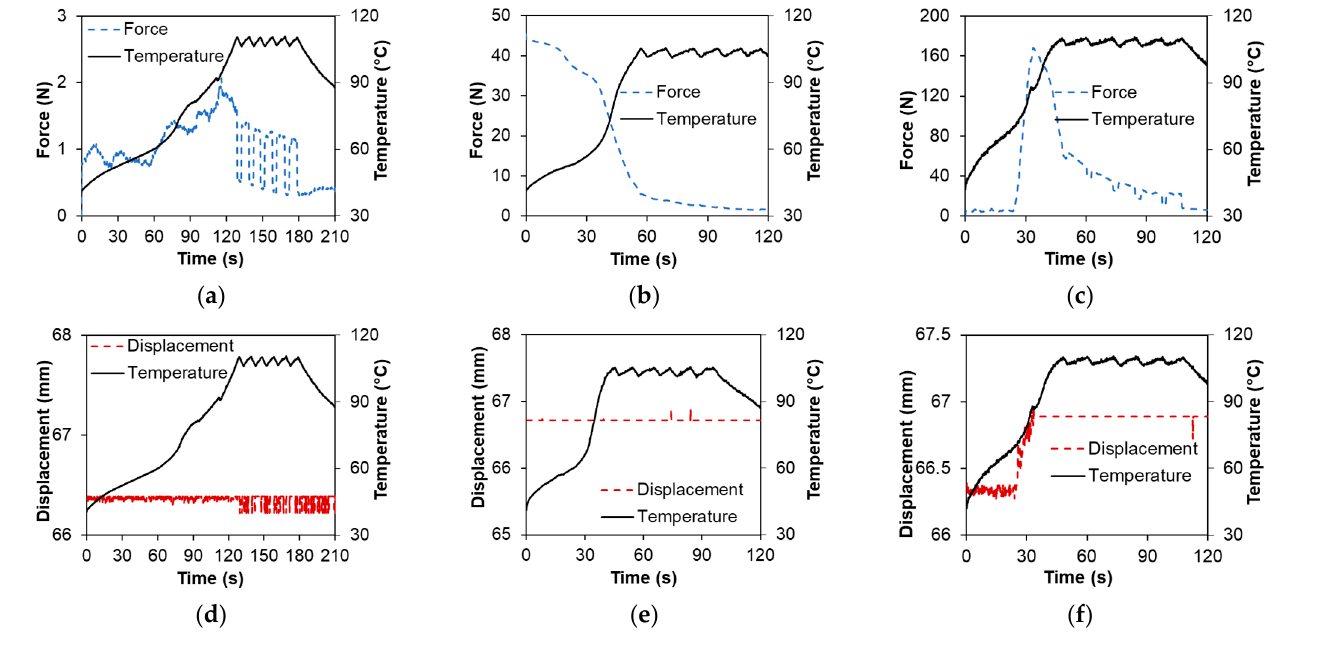
Figure 5. Change in force and temperature over the course of the experiments for ( a ) 75% graphite coverage with no pressure or displacement; for ( b ) 50% coverage, 0.3 MPa, and 0 displacement; and for ( c ) 50% coverage, 0.5 mm displacement, and no pressure. Change in displacement and temperature throughout the experiments for ( d ) 75% graphite coverage with no pressure or displacement; for ( e ) 50% coverage, 0.3 MPa, and 0 displacement; and for ( f ) 50% coverage, 0.5 mm displacement, and no pressure.